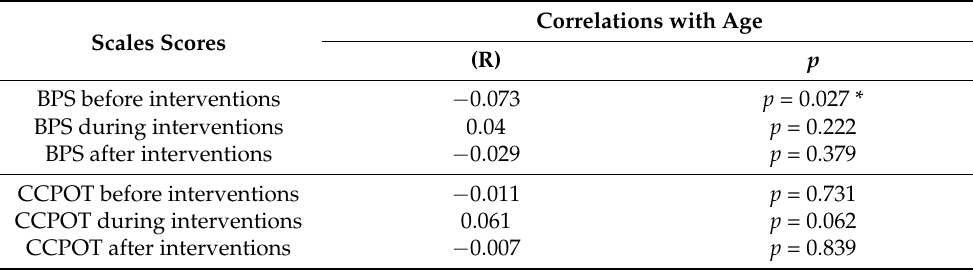
Table 7. BPS and CCPOT scores versus length of hospitalization (data from 1005 measures). Correlations with Length of Hospitalization Scales Scores R p BPS before interventions 0.055 p = 0.09 0.092